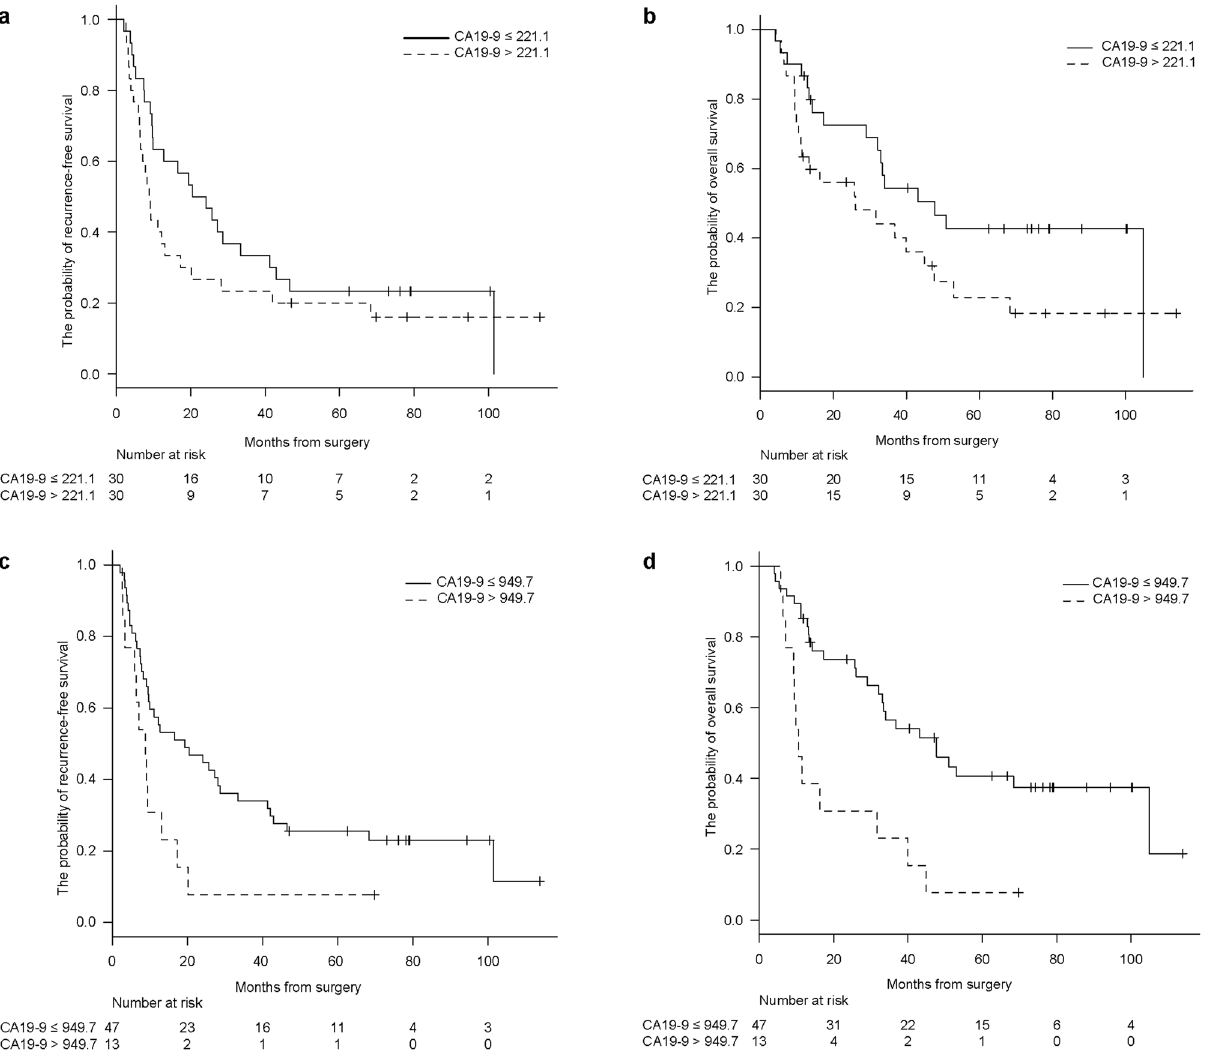
Figure 3. ( A, B ) Recurrence-free survival (RFS) and overall survival (OS) curves in patients who underwent surgery according to CA19-9 values (CA19-9 value ≥ 221.1 U/mL vs. CA19-9 value < 221.1 U/mL). The p-values were 0.21 and 0.15. The X-axis indicates the months from surgery, whereas the Y-axis indicates the probability of recurrence-free survival and overall survival. (C, D) Recurrence-free survival (RFS) and overall survival (OS) curves in patients who underwent surgery according to CA19-9 values (CA19-9 value ≥ 949.7 U/mL vs. CA19-9 value < 949.7 U/mL). The p-values were 0.020 and 0.001. The X-axis indicates the months from surgery, whereas the Y-axis indicates the probability of recurrence-free survival and overall